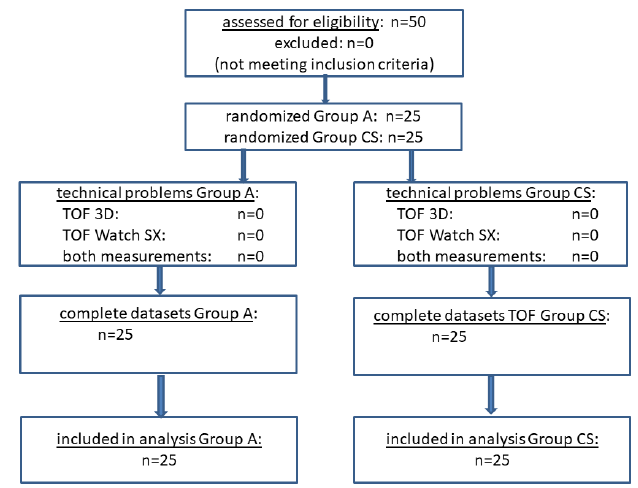
Figure 1. Consort flow diagram of the patients.